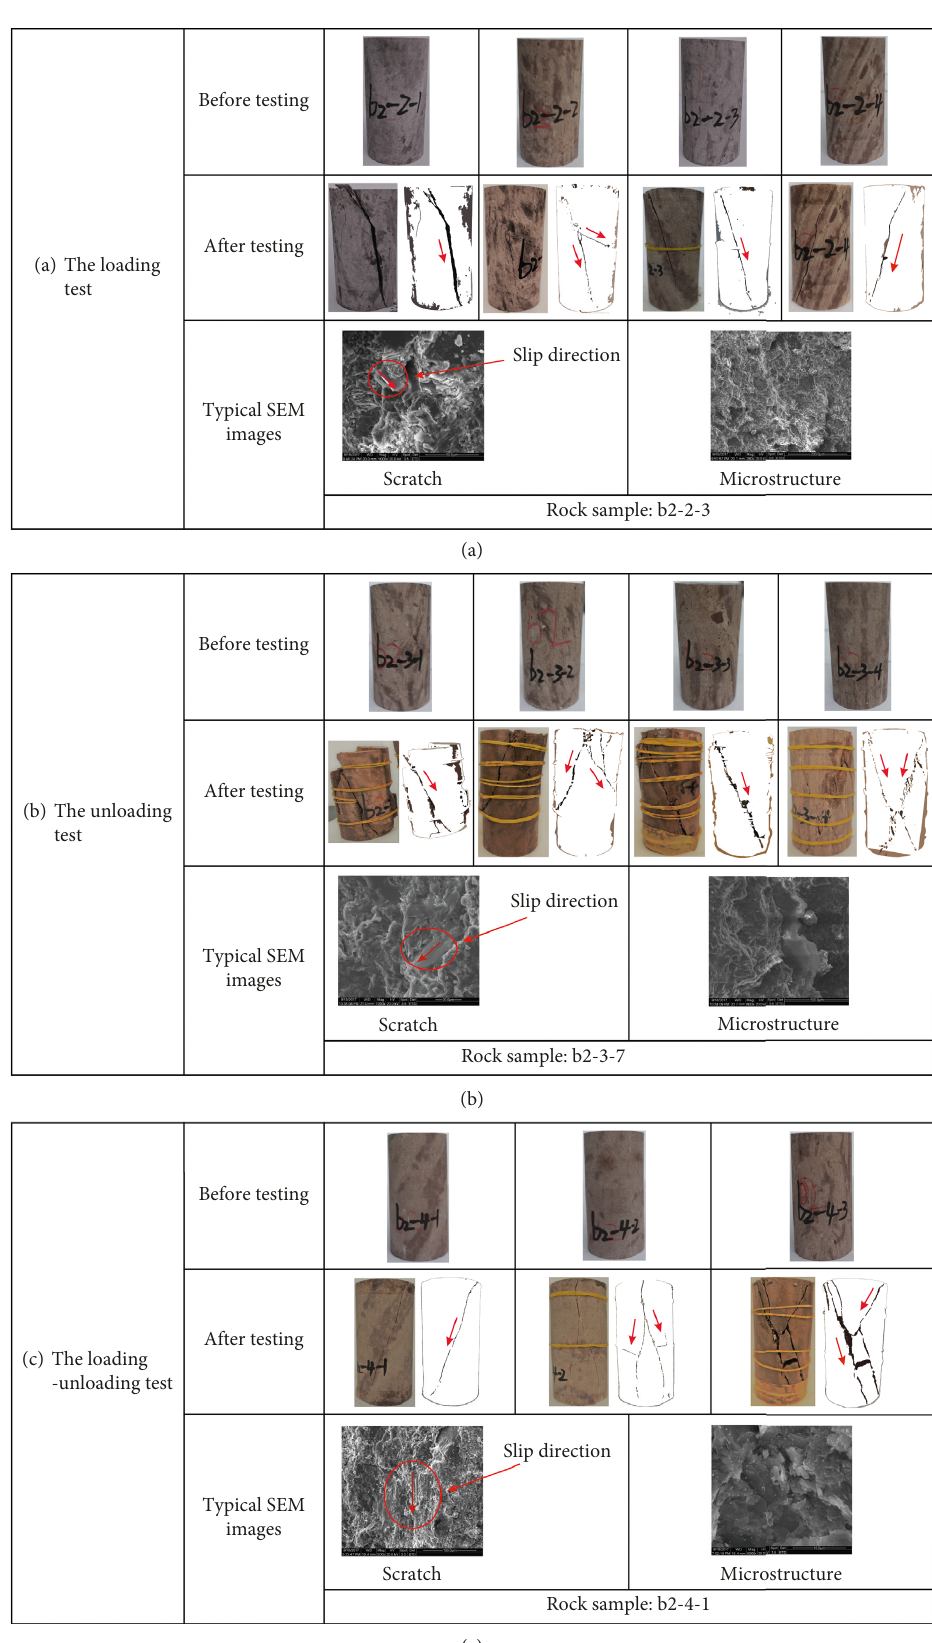
Figure 12: The failure modes and SEM images of rock specimens under different stress